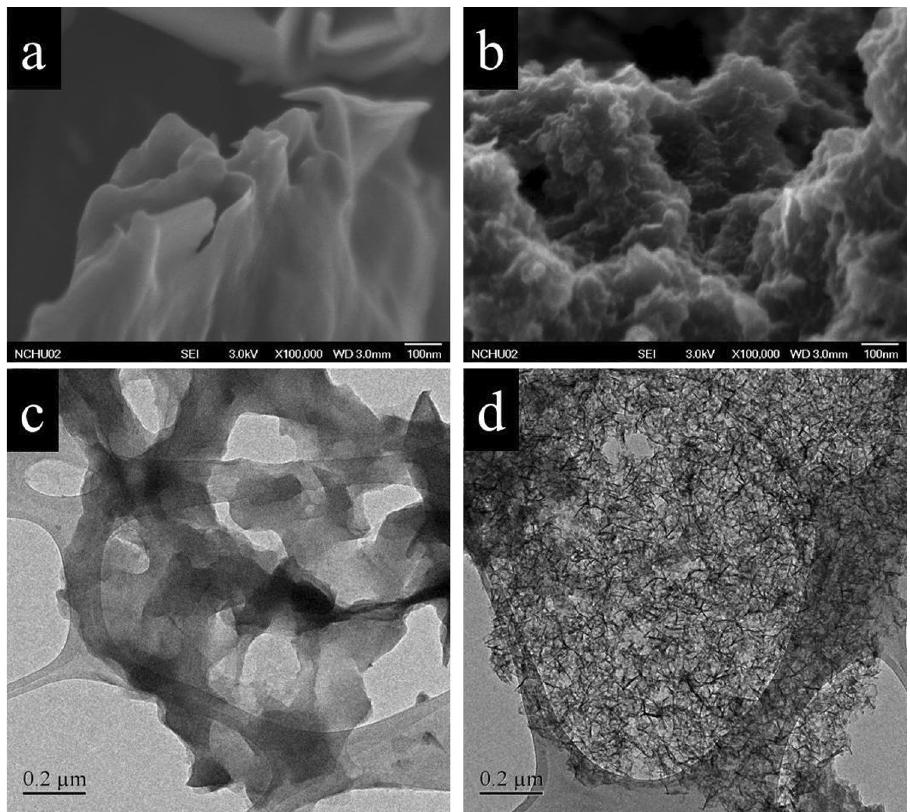
Figure 2. FESEM images of ( a ) rGO and ( b ) N-rGO; TEM images of ( c ) rGO and ( d )